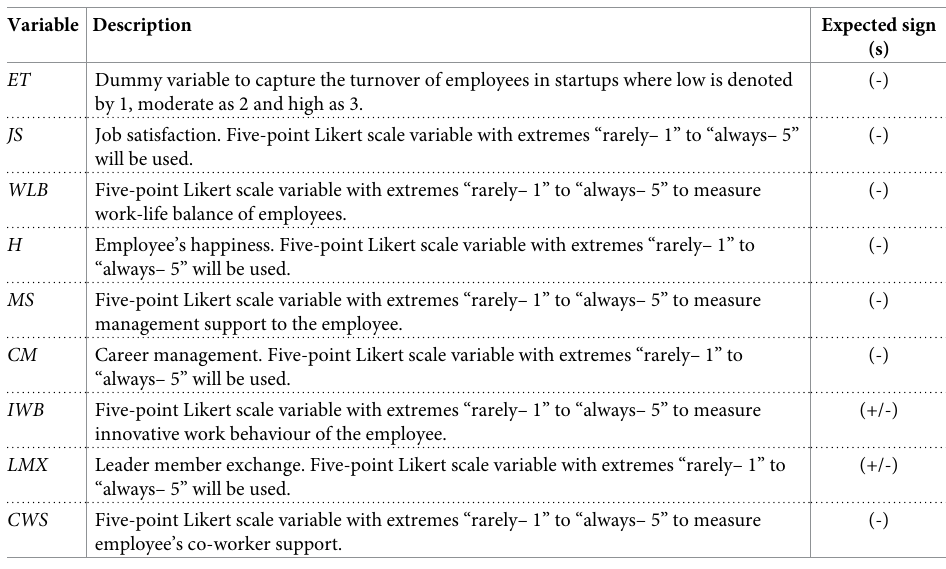
Table 2. Variable